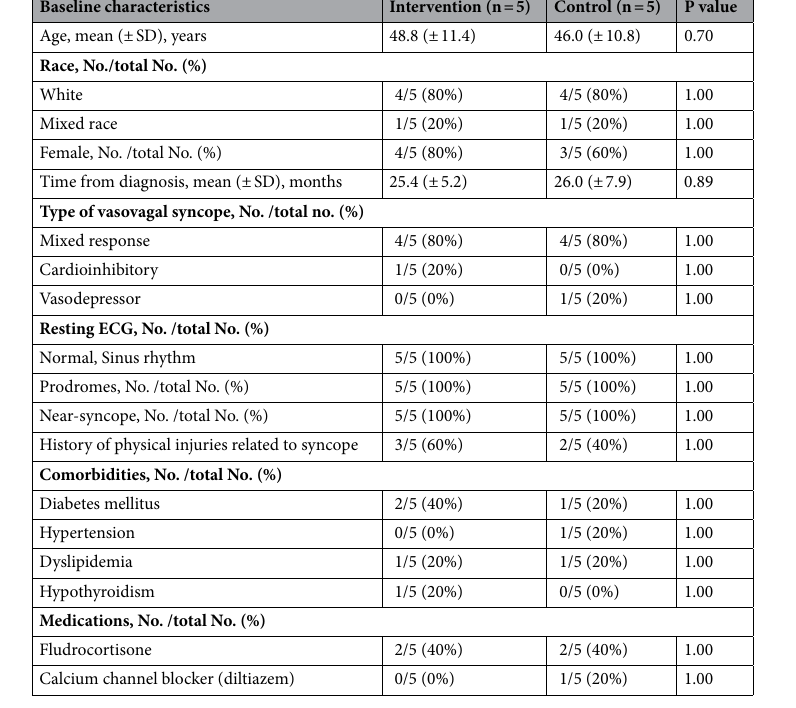
Table 1. Baseline characteristics of the patients.